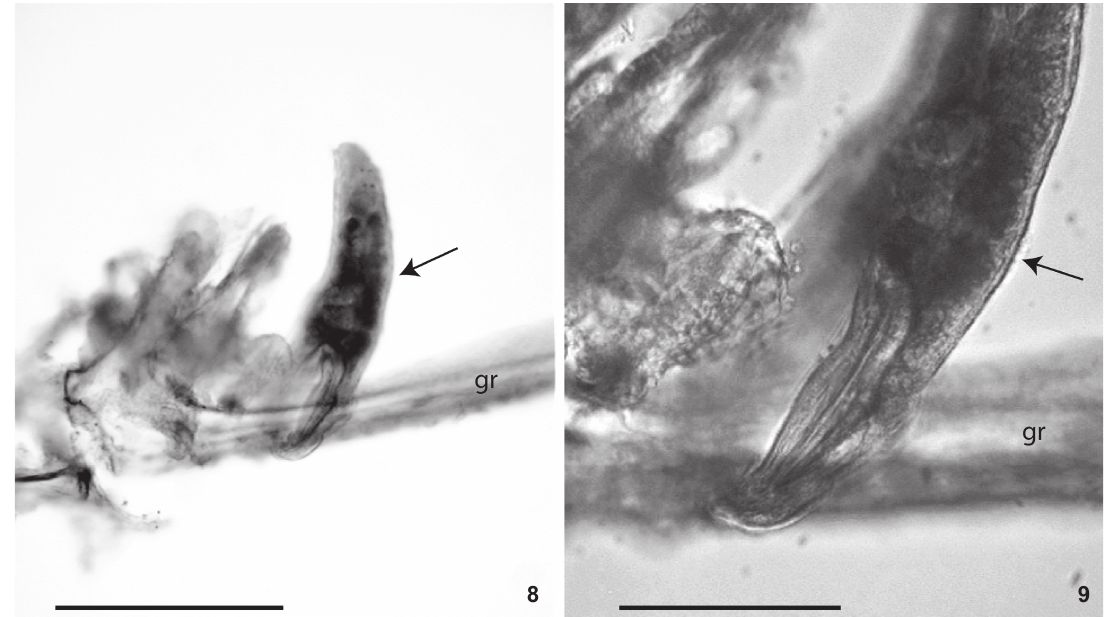
Figures 8-9. Photomicrographs of specimens of Susanlimae ianwhittingtoni sp. nov. (arrows) attached to the on the gill rakers (gr) of Pseudeutropius moolenburghae . Scale bars: 8 = 250 ìm, 9 = 100